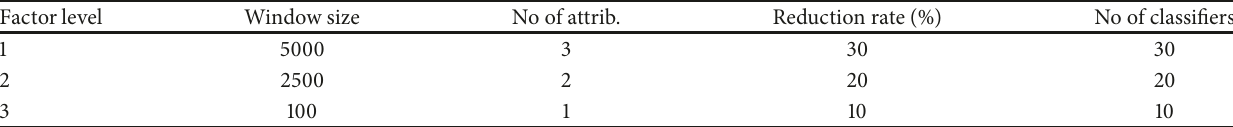
Table 4: Factor levels for the orthogonal array used in the experiment with the Sea dataset.